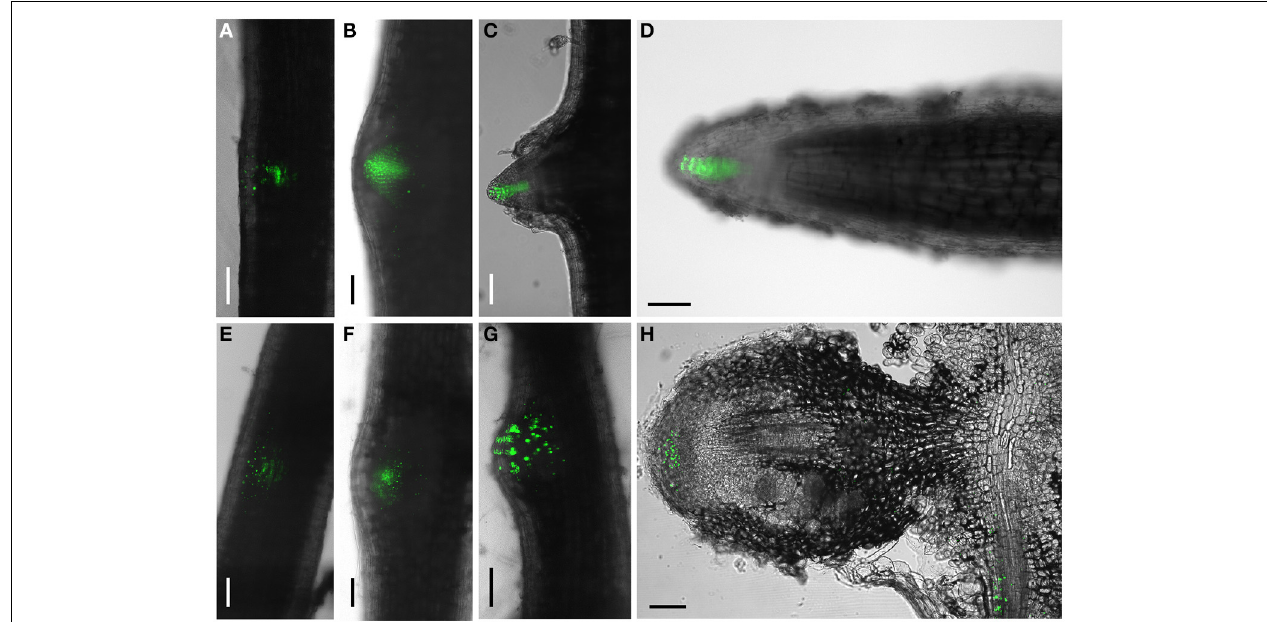
FIGURE 3 | DR5:VENUS:NLS expression pattern during lateral root and nodule development. (A–C) Lateral root: DR5 activation is gradually concentrated at the tip of developing lateral roots. (D) a mature lateral root showing VENUS fluorescence concentrated in the columella. (E–H)